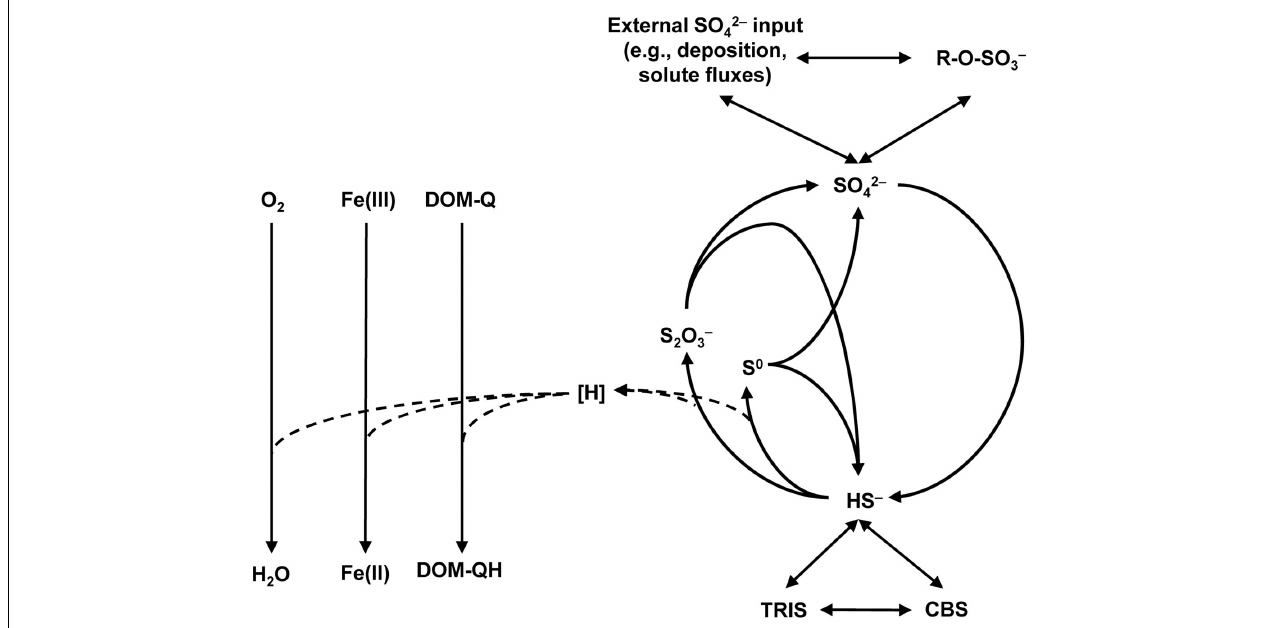
FIGURE 2 | Schematic overview of the proposed sulfur cycle in freshwater wetlands. Abbreviations: DOM-Q, quinone moieties of dissolved organic matter, R − O − SO − , organic sulfate esters,TRIS, total reactive inorganic sulfur, CBS, carbon bonded 3